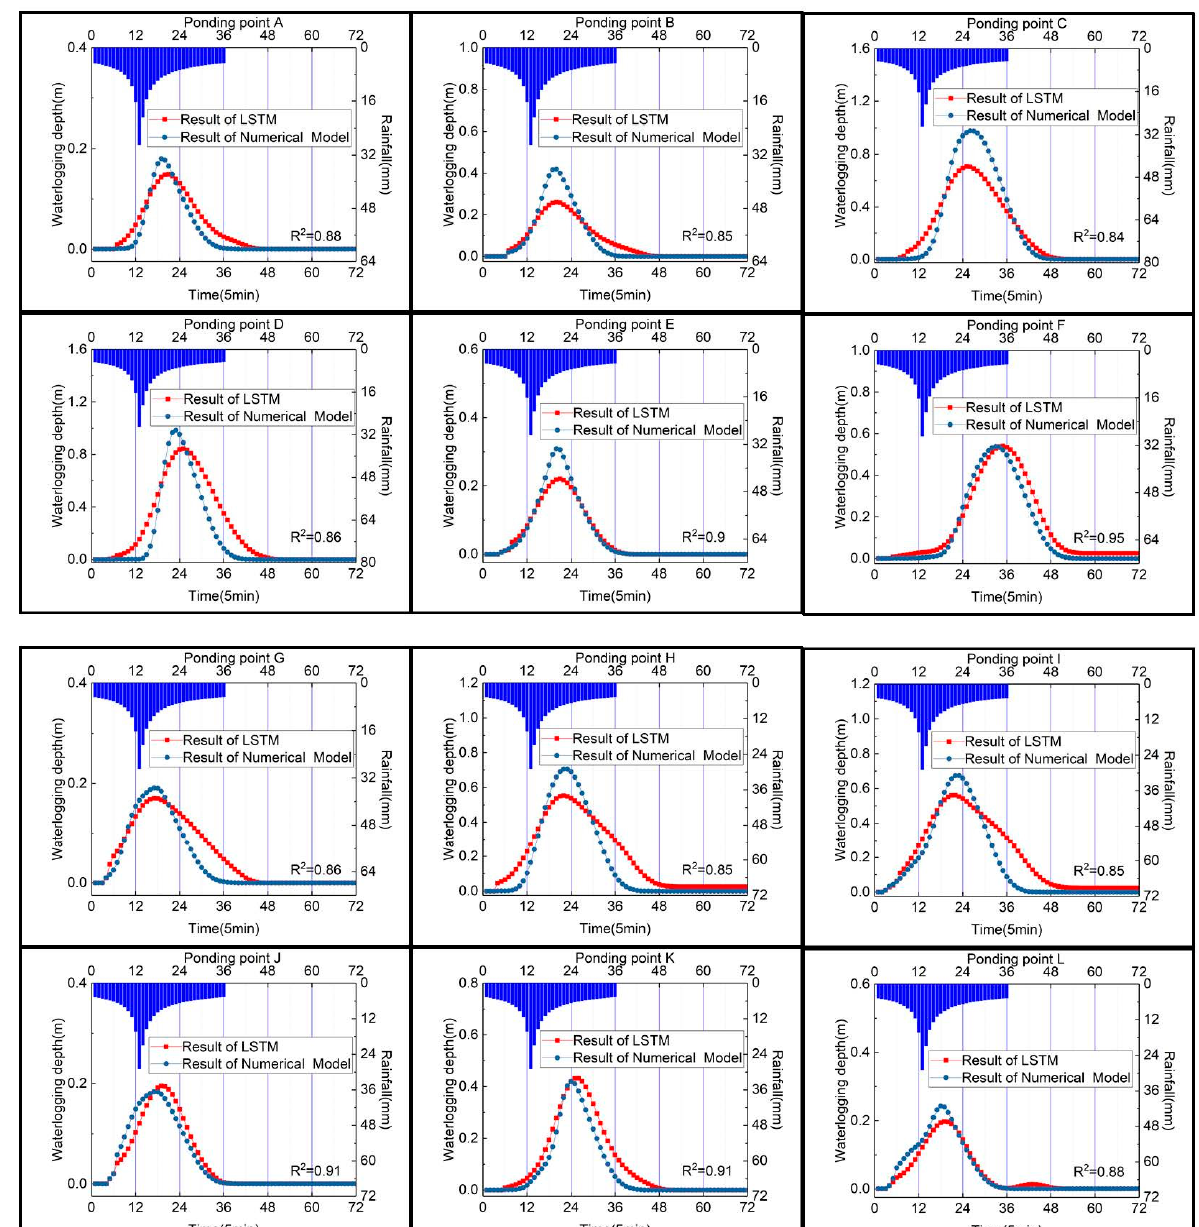
Figure 11. Simulation results of rainfall scheme with the Chicago rainfall pattern.